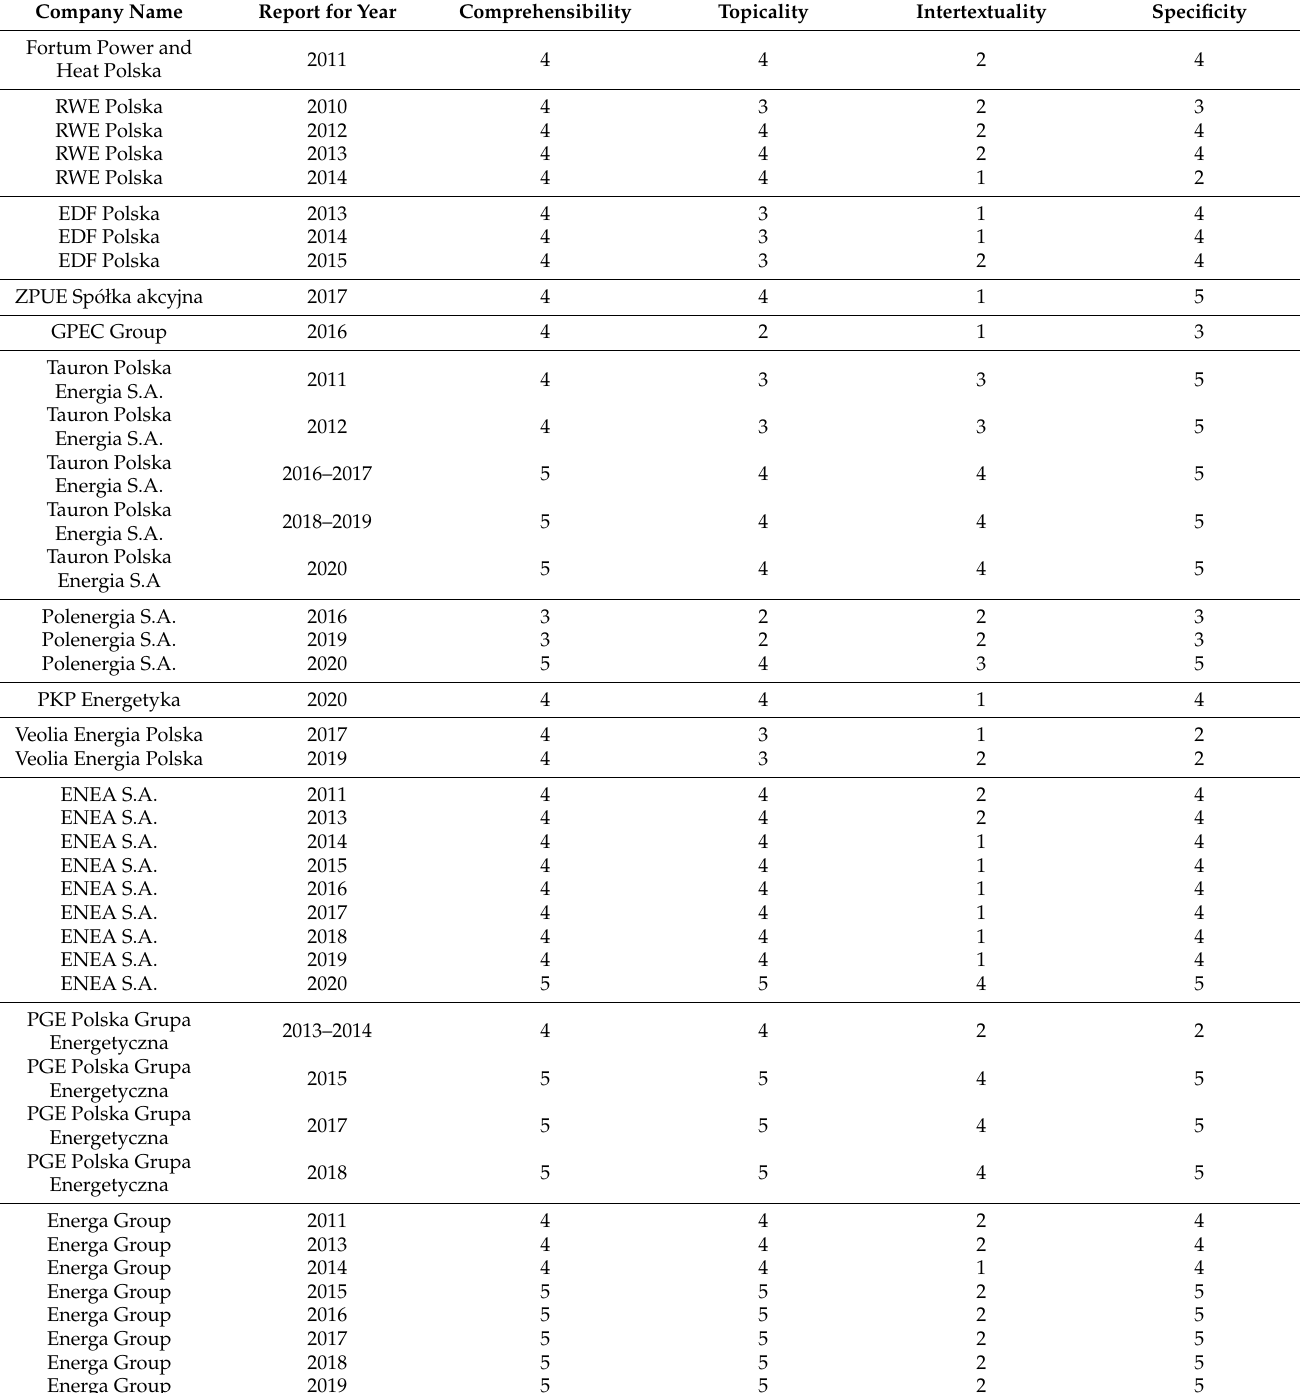
Table 7. Assessment of the EMS information included in energy companies’ non-financial